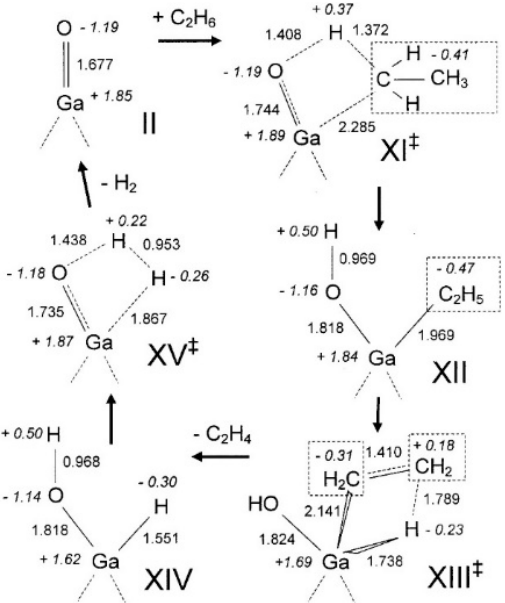
Figure 10. Reaction route for “alkyl” activation of ethane on the adsorbed gallyl ion. Reprinted with permission from ref [117]. Copyright 2000 American Chemical Society.